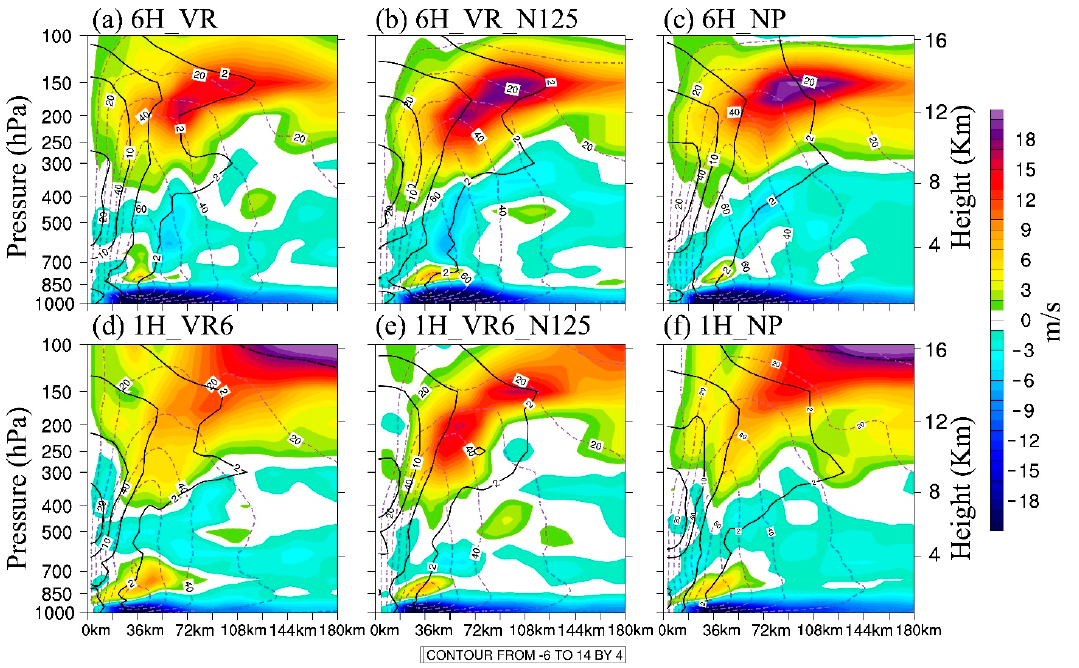
Figure 6. The azimuthal mean radial wind (shading), tangential wind (dashed contour), and tem- perature anomaly (solid contour) for ( a ) “6H_VR”, ( b ) “6H_VR_N125”, ( c ) “6H_NP”, ( d ) “1H_VR6”, ( e ) “1H_VR6_N125”, and ( f ) “1H_NP” valid at 12:00 UTC, 5 September 2017.